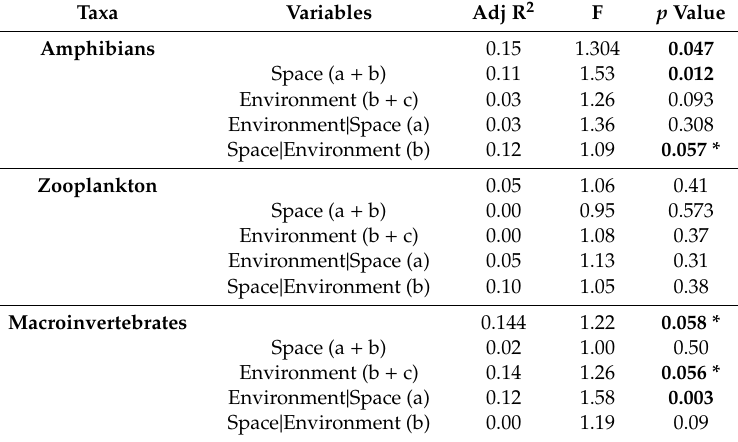
Table 1. p -values and pseudo F-statistics for RDA models for each taxonomic group and RDA model terms. Values were obtained via Monte-Carlo simulations. Bolded p -values are significant at α ~ 0.05 level.